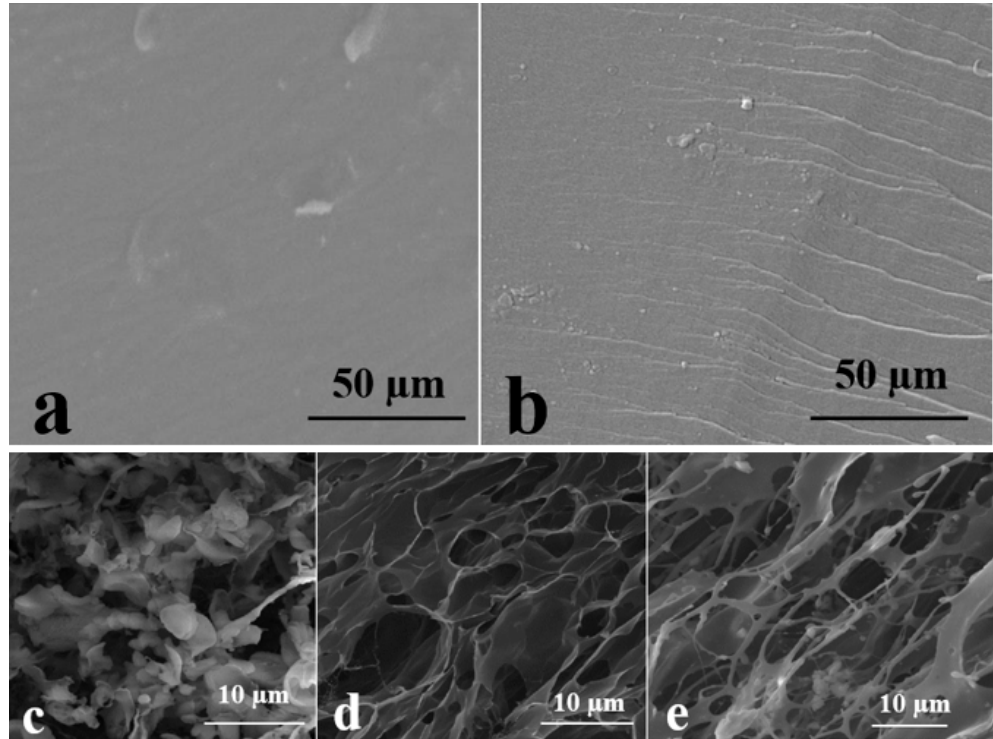
Figure 4. SEM images of dry ( a ) PVA and ( b ) PVA-PAA samples and the surface morphology of PVA-PAA samples at different pH values of ( c ) 5; ( d ) 7; and ( e ) 10.